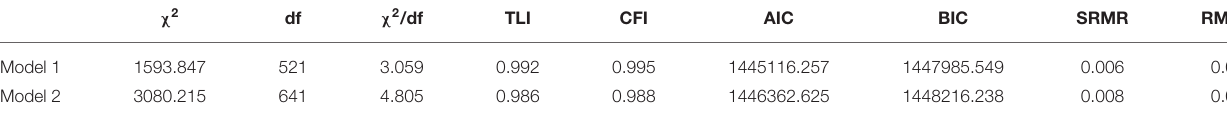
TABLE 3 | Model fit.